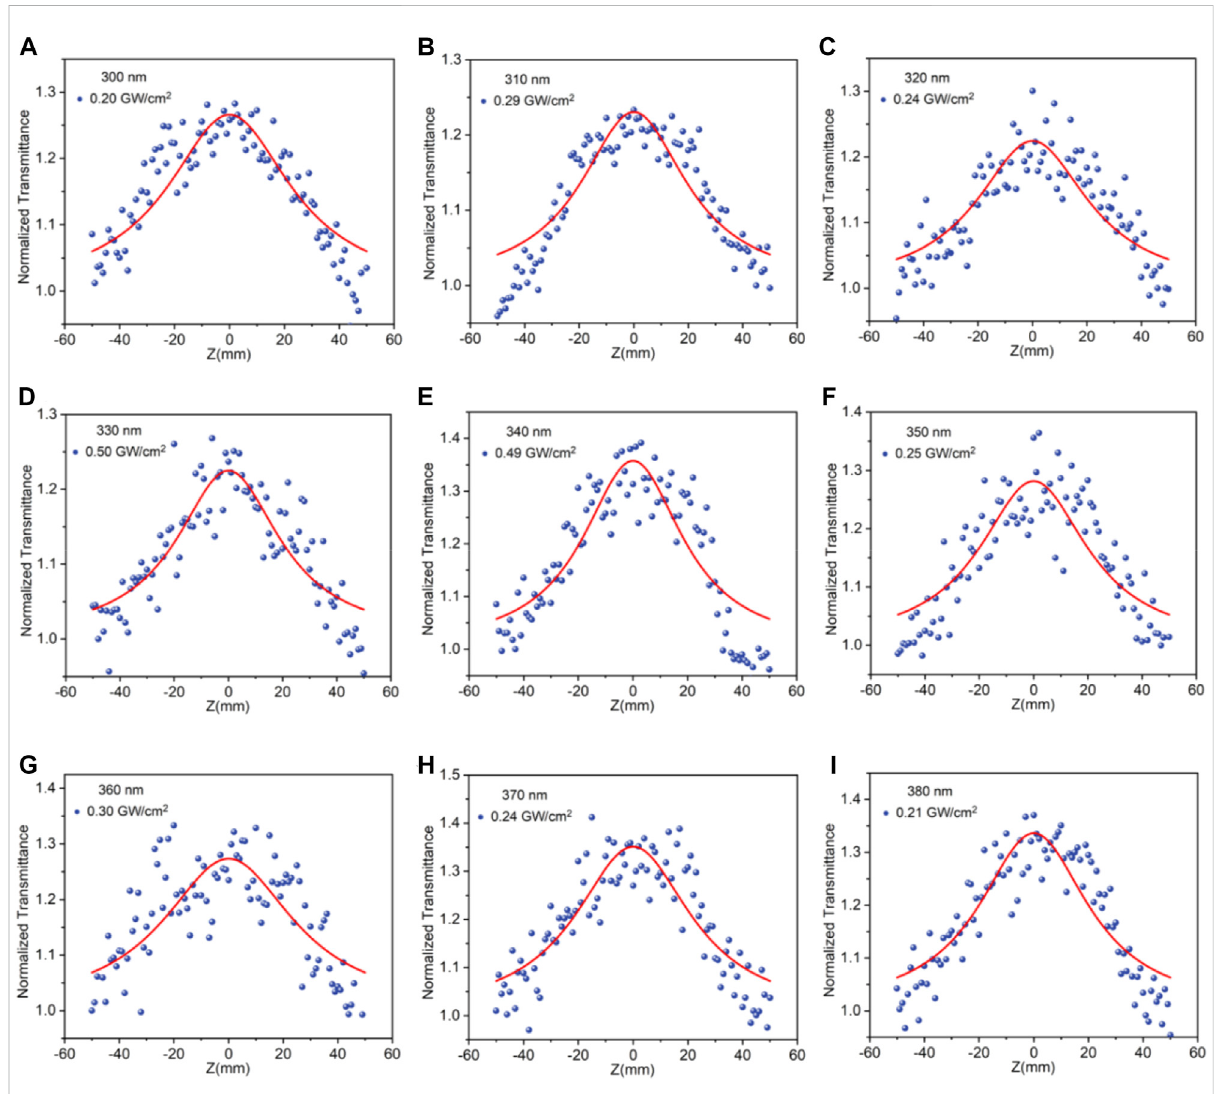
FIGURE 2 OAZ-scanresults ofBPQD-Ormosil gelglasses atexcitationintensities ofdifferentultravioletwavelengths. (A – I) :300,310,320,330,340,350, 360, 370, and 380